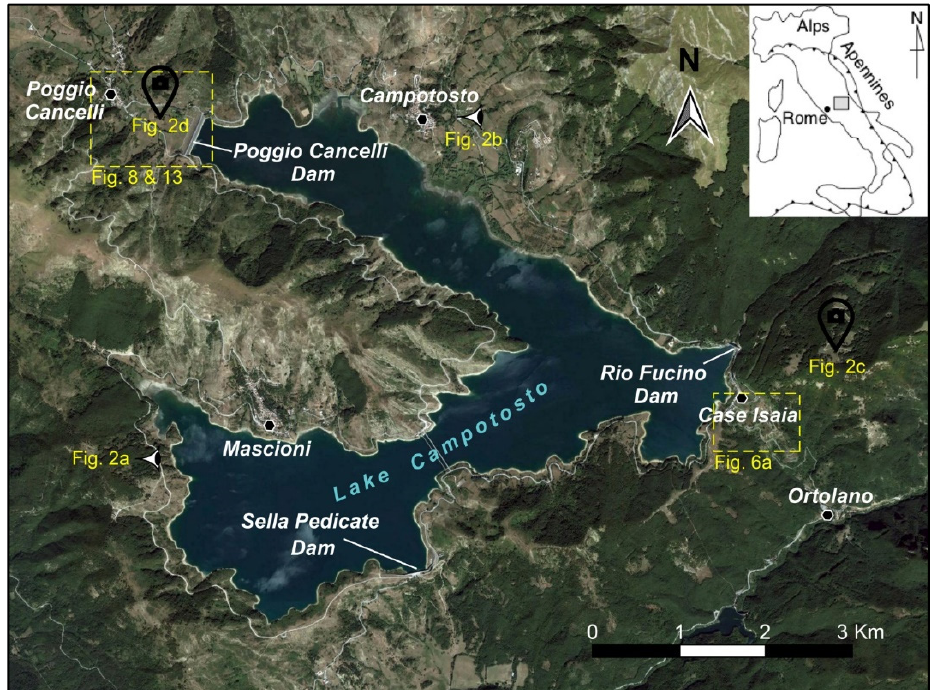
Figure 1. Satellite view of the Lake Campotosto area; the location of the following maps and photographs is also shown.